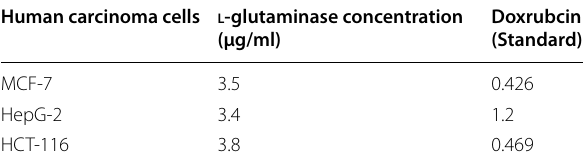
) for cytotoxicity activity 50